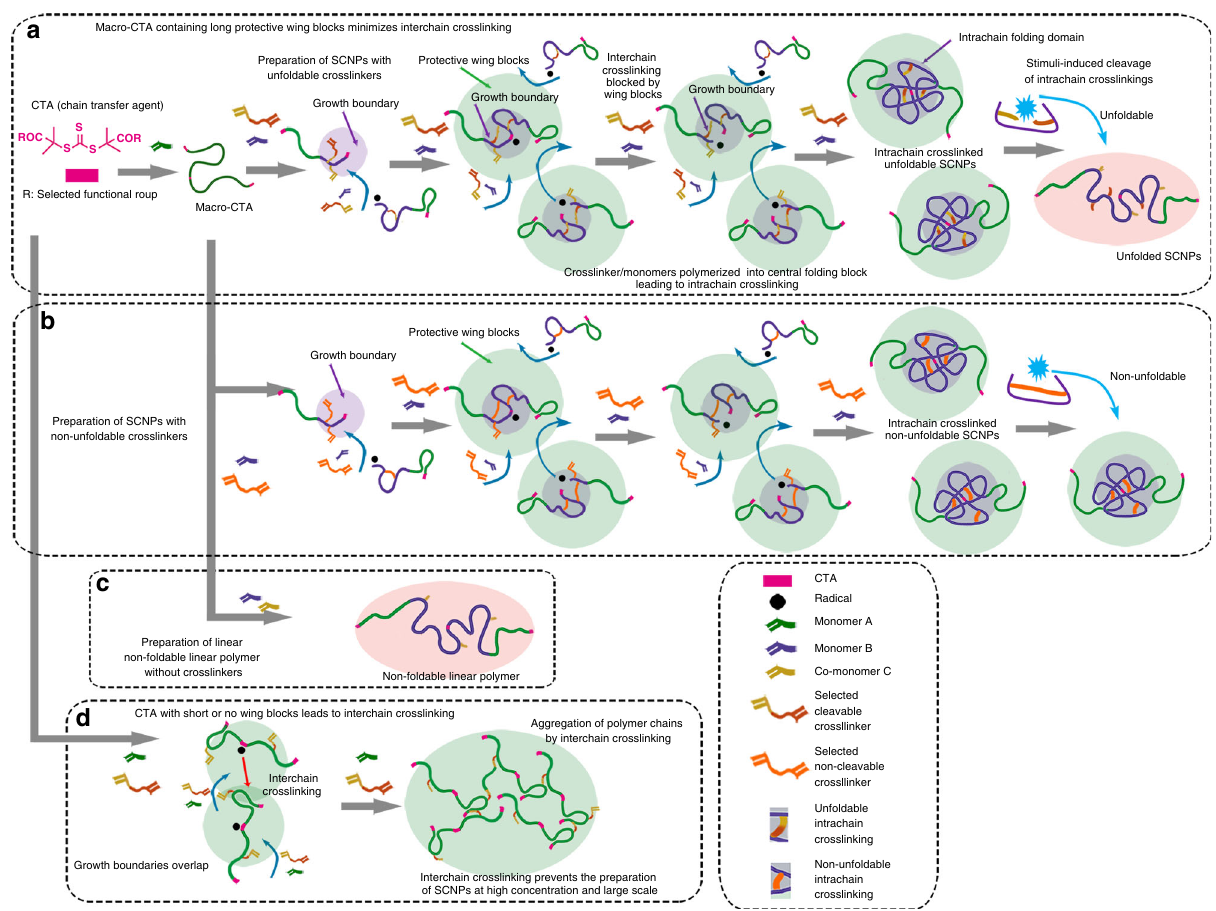
Fig. 2 Macro-CTAs containing long wing blocks minimize interchain crosslinking. a The successful scale-up preparation of unfoldable SCNGs mediated by macro-CTA containing long protective wing blocks (green sphere). The growth boundary (purple sphere) of each polymer chain is embedded in the long wing blocks, thereby preventing interchain crosslinking at a high reactant concentration. b The procedure of preparing non-unfoldable SCNGs. c The scheme of preparing a non-foldable linear control polymer (orange sphere). d Illustration of the failed preparation of SCNGs mediated by CTAs with short or no wing blocks. The growth boundaries of the polymer chains easily overlap at high